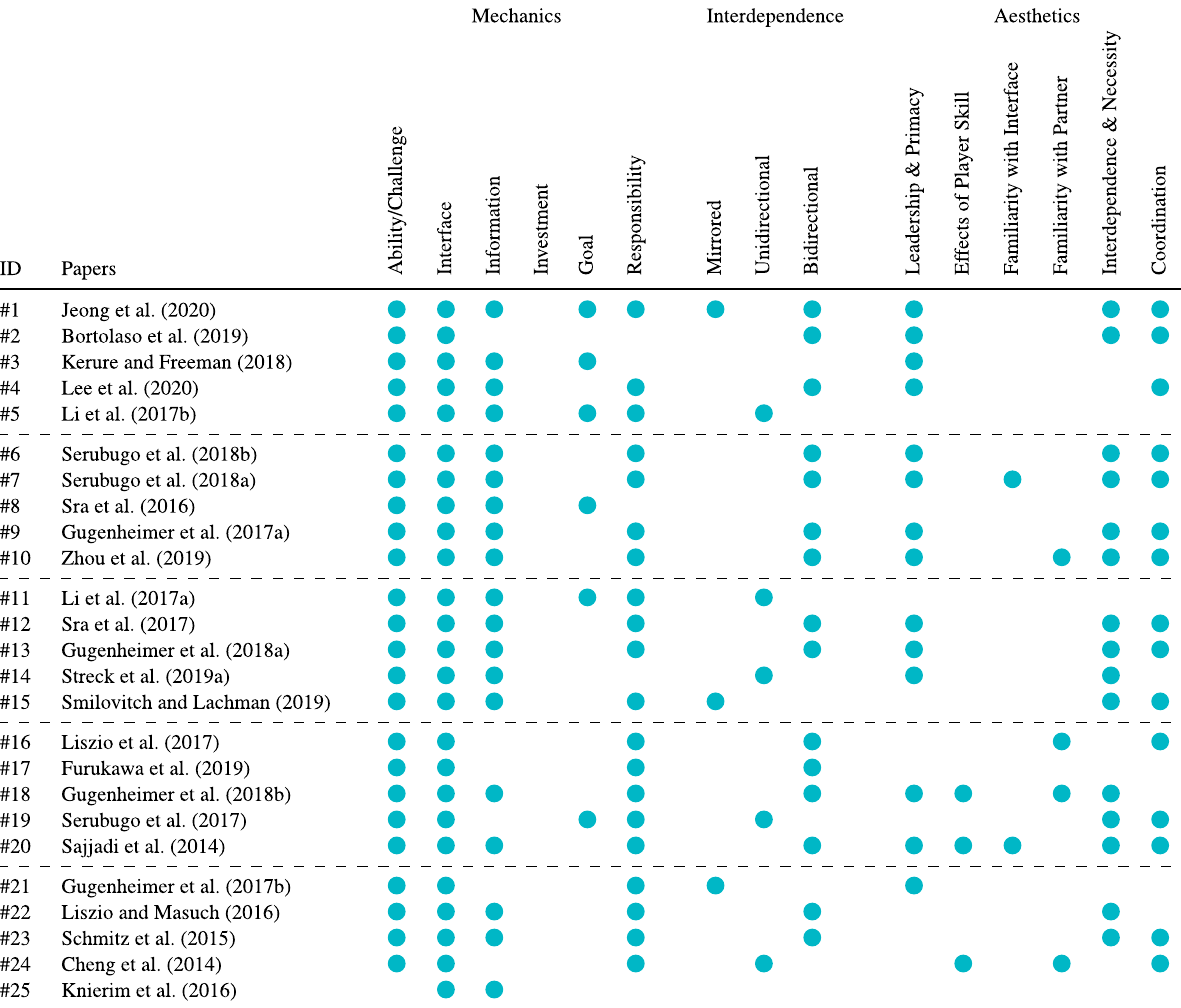
TABLE4| Anoverviewofhowthe fi nalcorpusofsurveyedpapers fi tsintothe(Harrisetal.partofthe) posthoc framework.Emptiercolumnsindicateexistingresearchgapsin the fi eld.